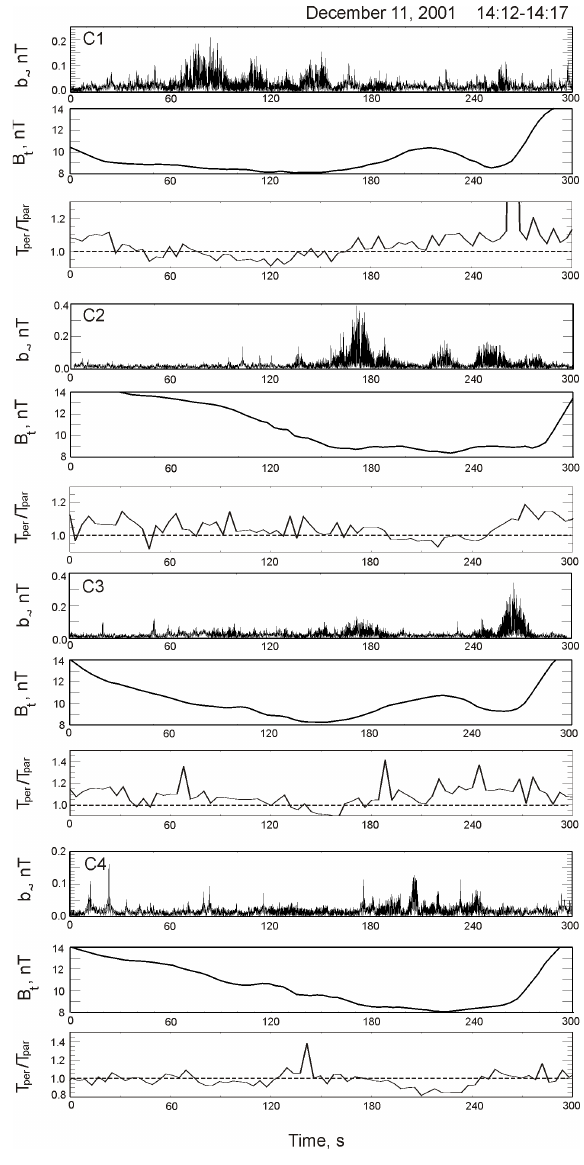
Fig. 4. Intensity of whistler emissions, the magnetic field strength and factor of the electron anisotropy T e ⊥ /T e k